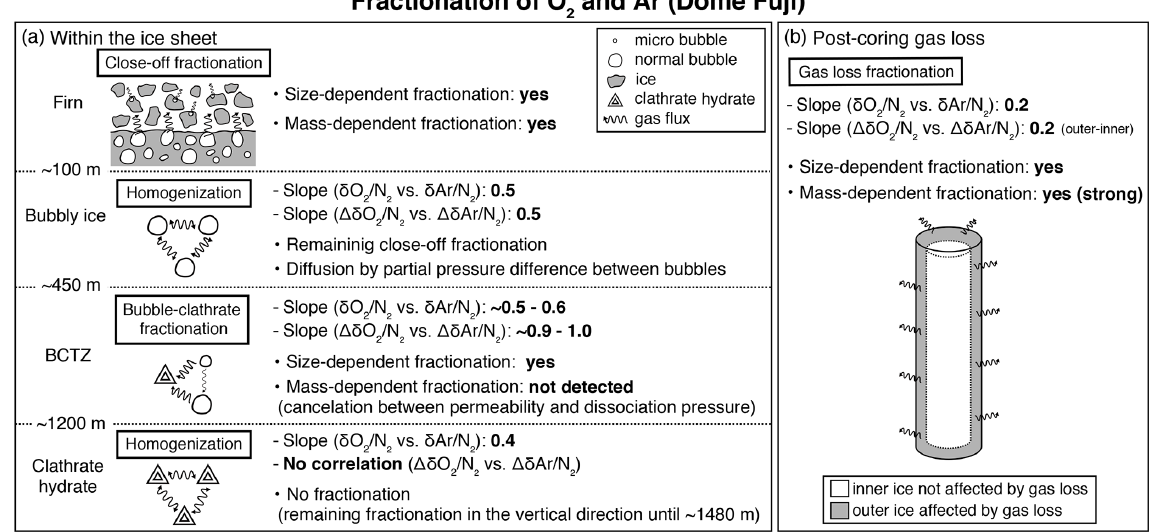
Figure 11. Schematic of fractionations of O 2 and Ar (a) within the ice sheet at Dome Fuji and (b) for the post-coring gas loss. The slopes were taken by the bulk data and the pair difference of δ O 2 / N 2gravcorr and δ Ar / N 2gravcorr , respectively (see Fig. 10). The descriptions of “yes” indicate the observed results (this study; Severinghaus and Battle, 2006; Huber et al., 2006; Battle et al.,